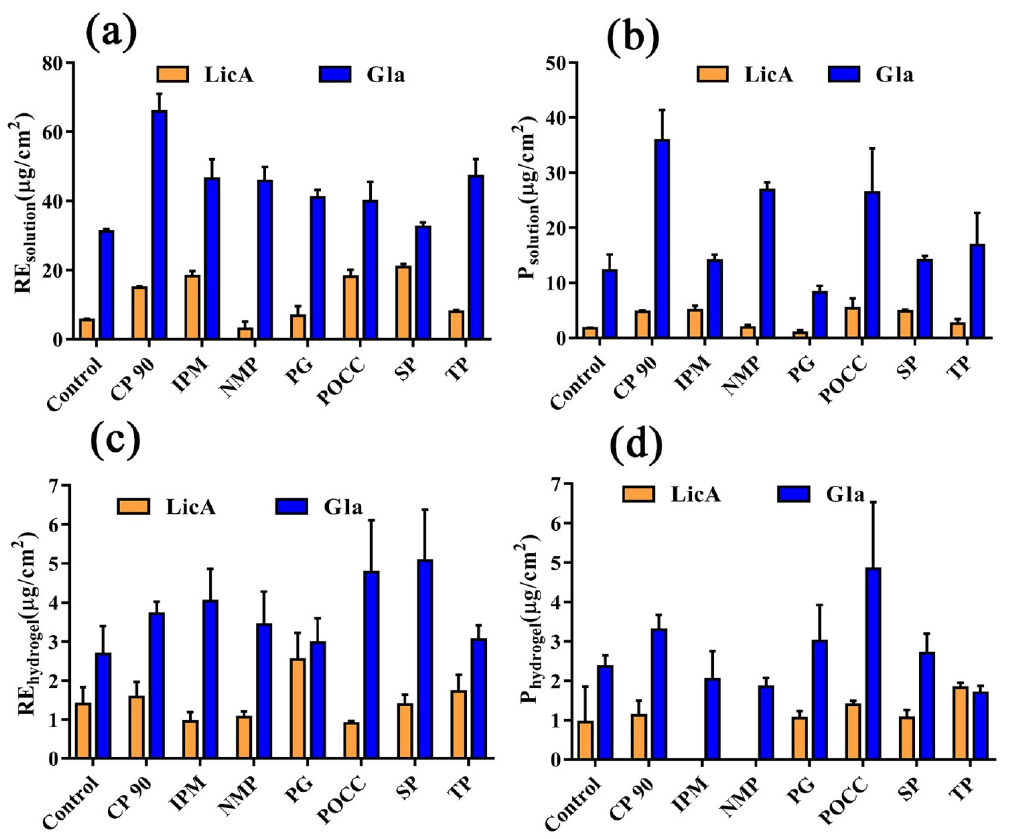
Figure 6. ( a ) RE solution of LicA and Gla after 48 h ( n = 4); ( b ) P solution of LicA and Gla after 48 h ( n = 4); ( c ) RE hydrogel of LicA and Gla after 48 h ( n = 4); ( d ) P hydrogel of LicA and Gla after 48 h ( n = 4).